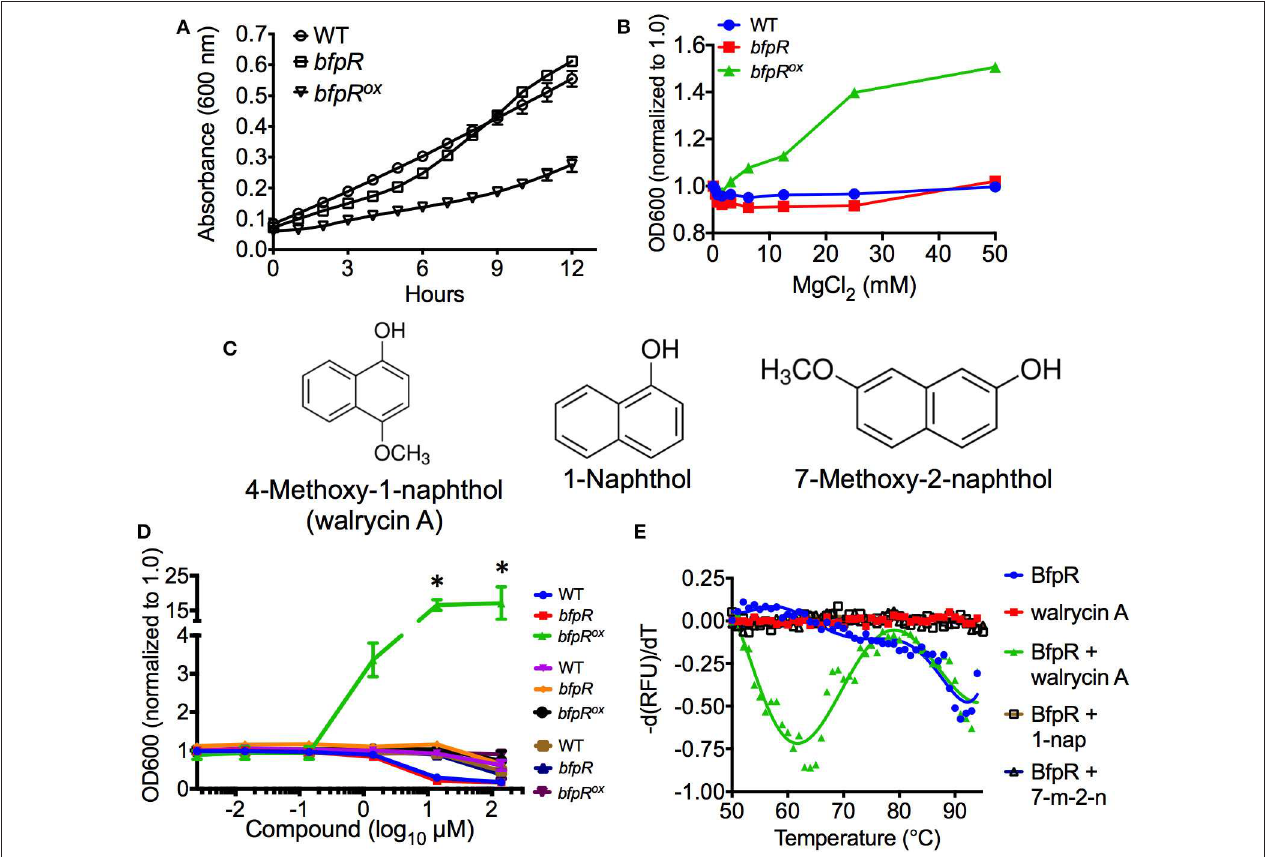
FIGURE 7 | bfpR overexpression growth defect and growth induction by Mg 2 + and inhibitor. (A) The growth rates of WT and bfpR in TSBC. (B) The growth of WT and bfpR in TSBC with increasing concentration of MgCl 2 . (C) Chemical structures of walrycin A (4-Methoxy-1-naphthol), 1-Naphthol, and 7-Methoxy-2-naphthol are shown. (D) WT, bfpR, and bfpR ox with a titration of walrycin A (blue, red, green) and control compounds 1-naphthol (purple, orange, black) and 7-Methoxy-2-naphthol (brown, navy blue, and maroon). The data normalized to 1.0 for untreated. (E) Differential scanning fluorimetry using SYPRO Orange was performed on BfpR-His 6 with and without walrycin A, 1-Naphthol, or 7-Methoxy-2-naphthol. Walrycin A: wal A, 1-Naphthol: 1-nap, 7-ethoxy-2-naphthol: 7-m-2-n. Data are shown as averages from three independent experiments, error bars indicate standard deviation, and significance was determined by Student’s t -test. * p <